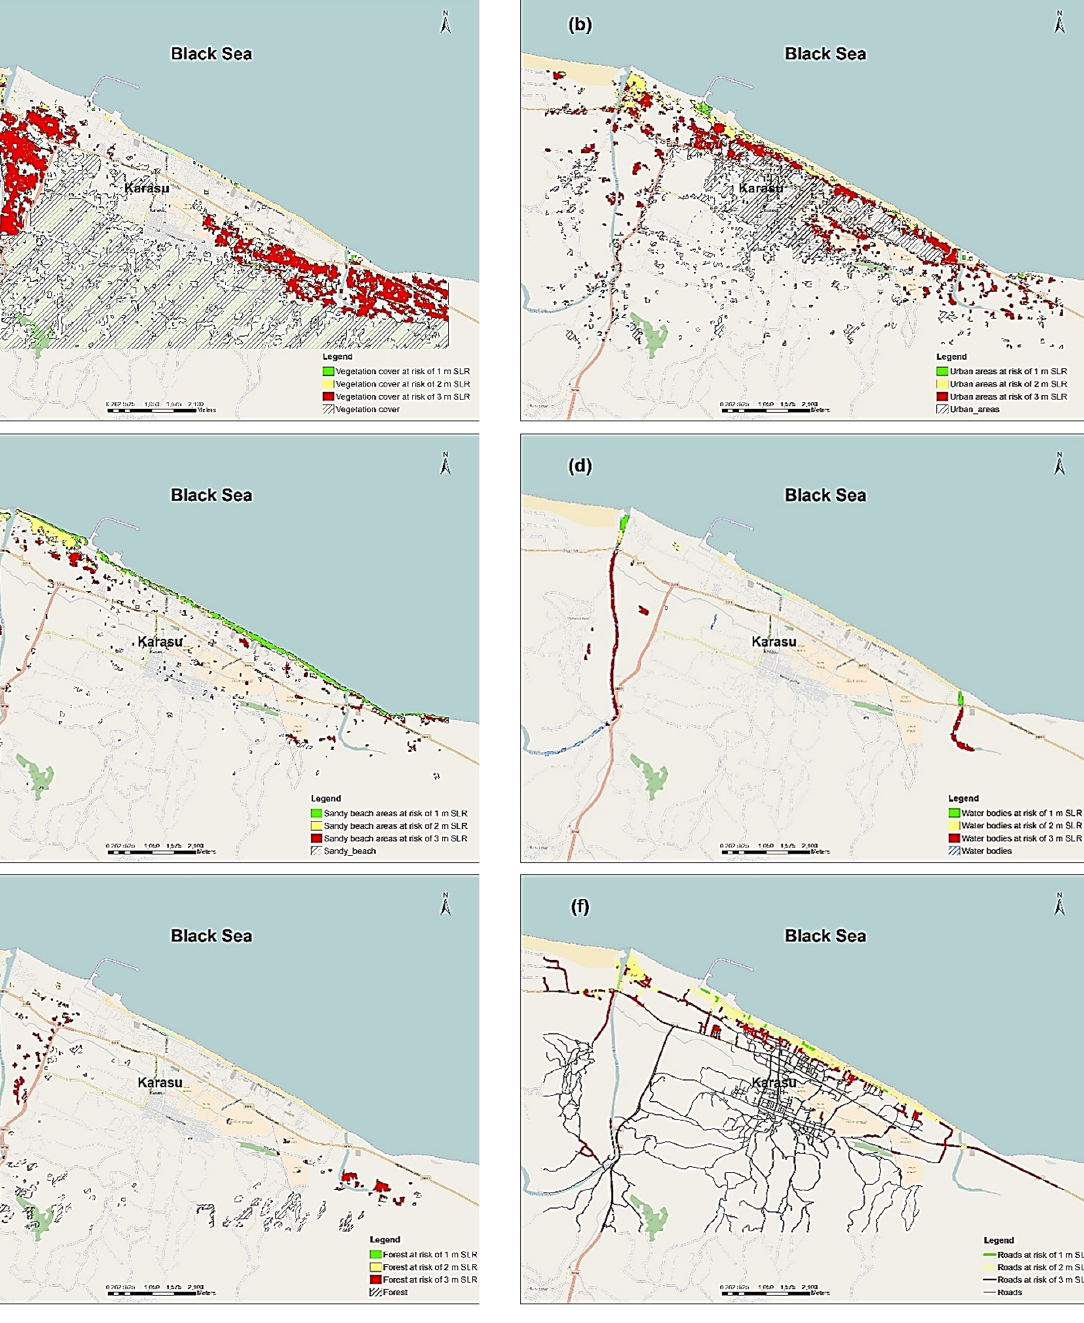
Figure 6. Risk maps of land use of the study area caused by inundation of 1, 2, and 3 m SLR: ( a ) Vegetation cover; ( b ) Urban areas; ( c ) Sandy beach; ( d ) Water bodies; ( e ) Forest; ( f ) Roads [37].